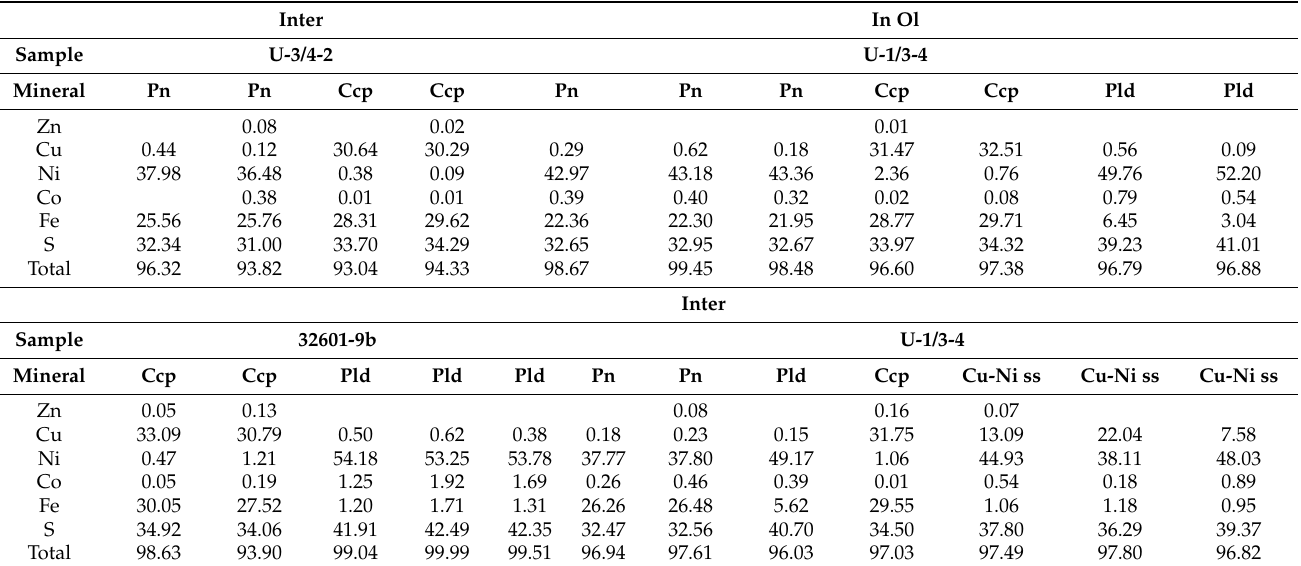
Table 1. Representative SEM analyses of sulfides in Cpx-poor Spl lherzolites from East Antarctica (wt%).